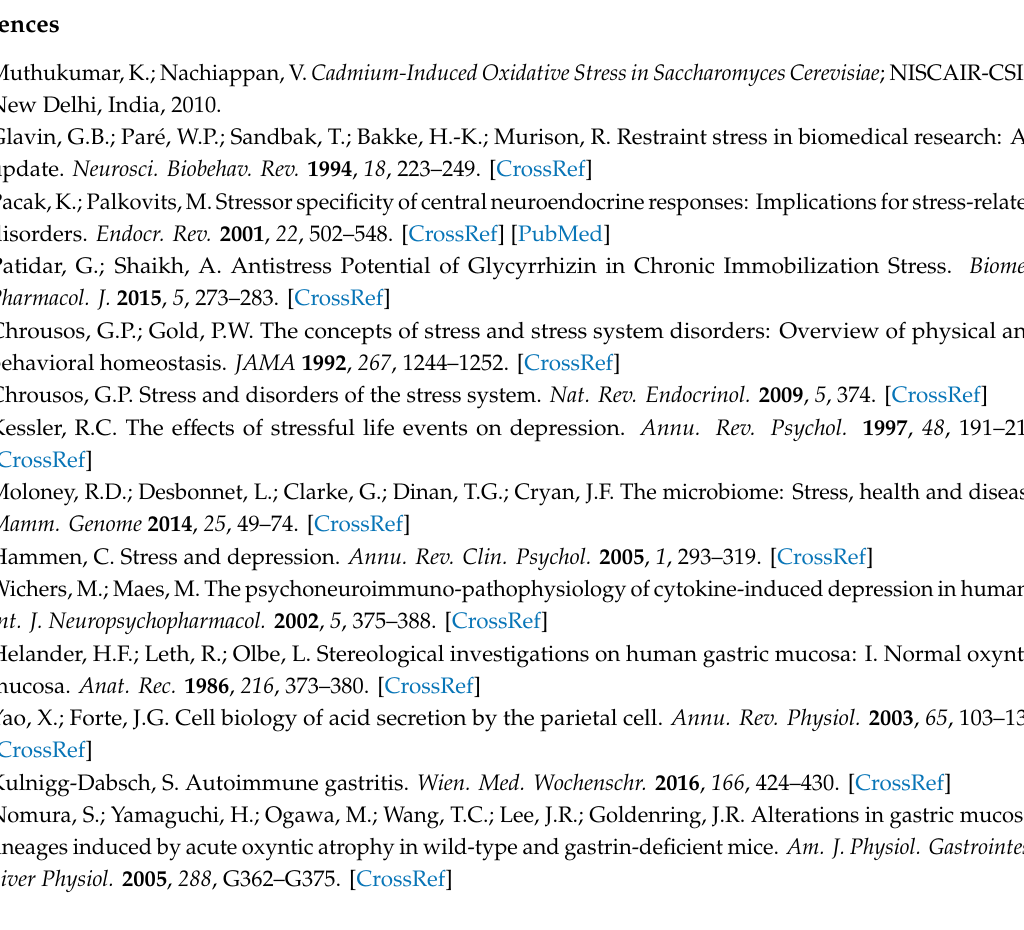
Figure S1: The supplementary figure showed the brief experimental design including the restraint stress protocol for 4 h daily for 15 consecutive